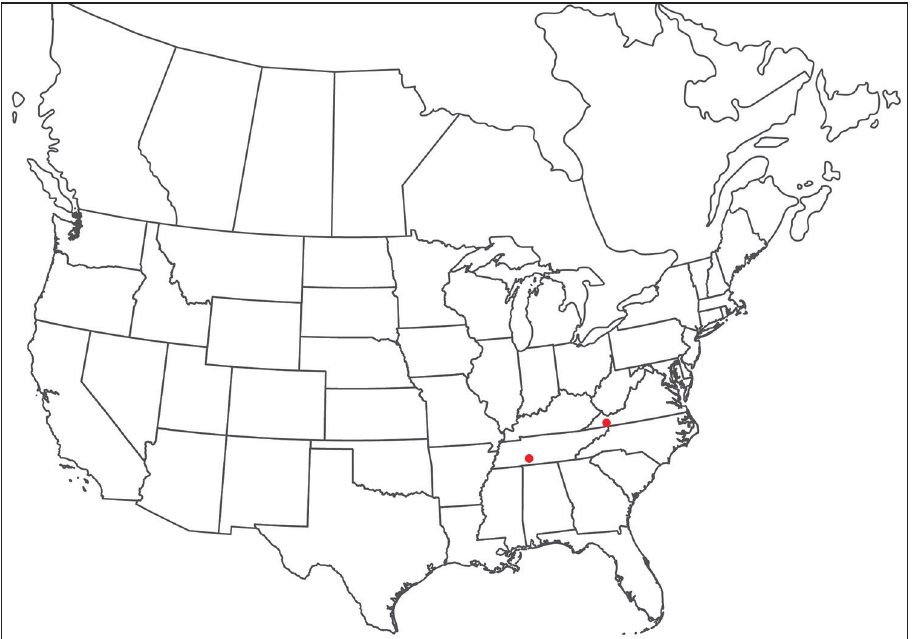
Figure 205. Torrenticola racupalpa sp. n.